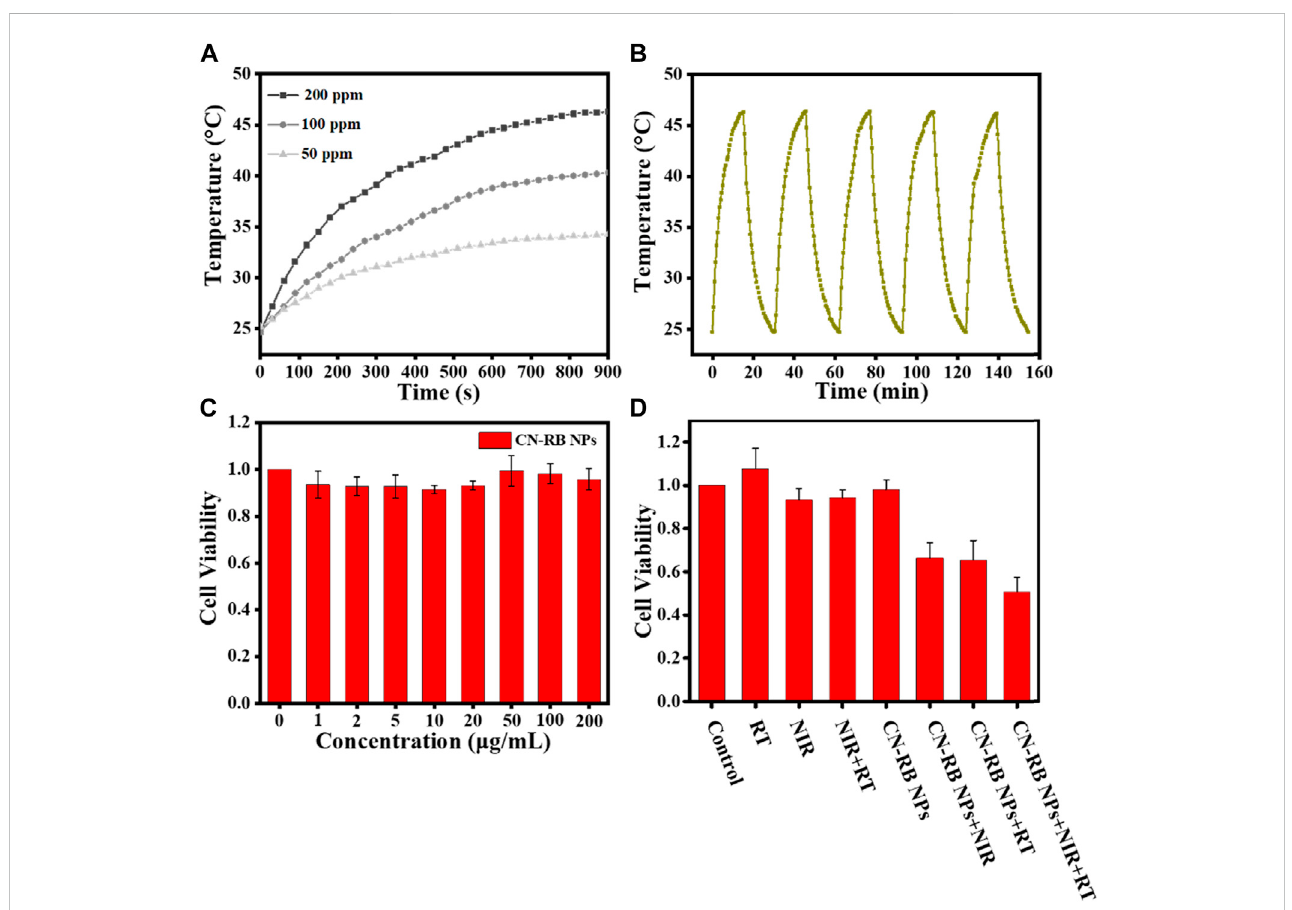
FIGURE 2 (A) The photothermal effect of different concentrations of CN-RB NPs solution under 1064 nm laser irradiation (2 W cm − 2 ). (B) The photothermal effect of CN-RB NPs solution of 200 ppm over fi ve cycles under 1064 nm laser irradiation (2 W cm − 2 ). (C) Cell viability of 4T1 breast cancer cells exposed to CN-RB NPs at different concentrations (n = 5, p < 0.05). (D) Relative cell viability of each group evaluated using MTT assay ( n = 5, p <